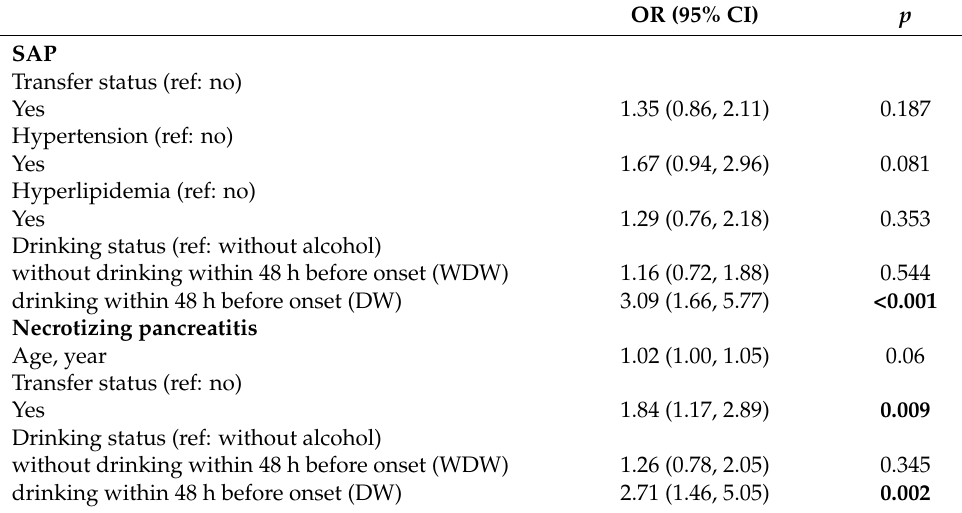
Table 6. Multivariate logistic regression analysis for the association of patients’ demographic characteristics with the risk of SAP and necrotizing pancreatitis among DW group, WDW group and WA